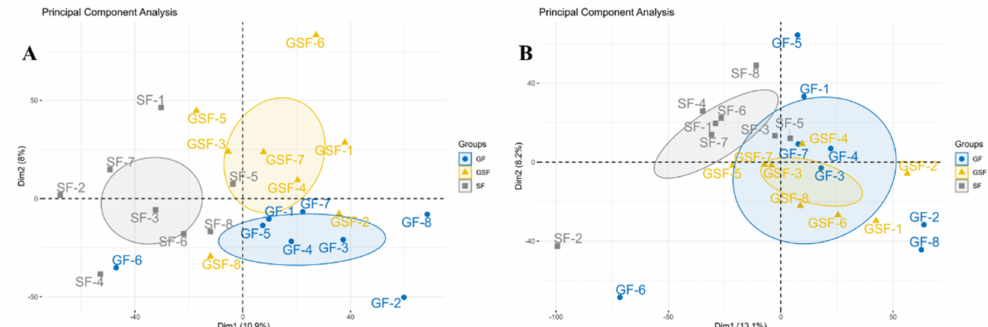
Figure 1. PCA analysis of metabolites under positive- ( A ) and negative- ( B ) ion modes in LD muscle of Tan lamb. GSF, graze-feeding group; GF, time-limited graze-feeding group; SF, stall-feeding group. n = 8 for each group.